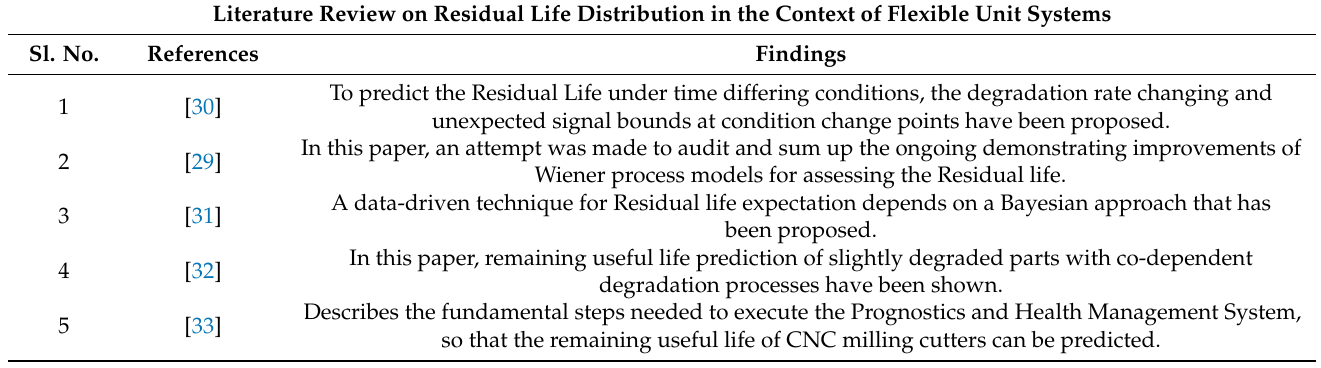
Table 7. Literature review on residual life distribution related to flexible unit systems.